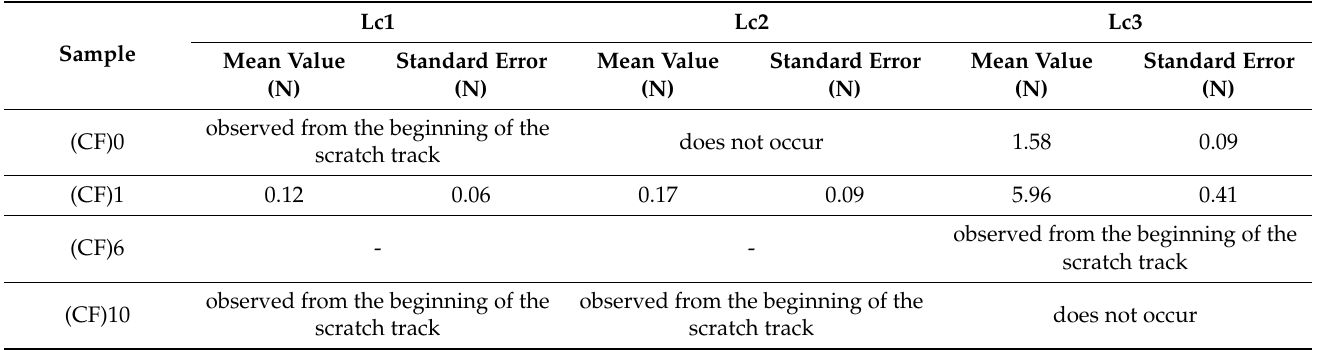
Table 4. Values of critical loads determined by scratch